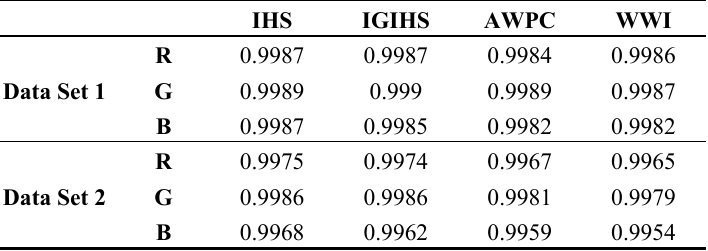
Table 2. Closeness of fused and reference multispectral (MS) image Modulation Transfer Function (MTF) values.